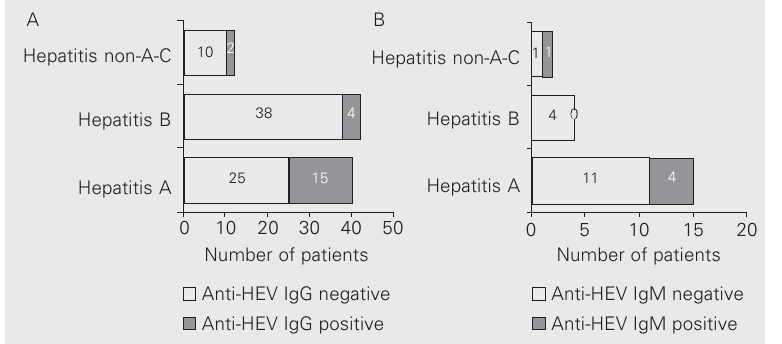
Figure 1. A , Prevalence of serum anti-HEV IgG antibodies in patients with acute hepatitis. Anti-HEV IgG was significantly more prevalent in patients with hepatitis A compared to the hepatitis B group (P = 0.003, chi-square test). Comparison between hepatitis A vs non-A-C groups showed P = 0.294, and comparison between the hepatitis B group and the non-A-C hepatitis group showed P = 0.605 (Fisher exact test). B , Prevalence of serum anti-HEV IgM antibodies in patients with acute hepatitis who were anti-HEV IgG